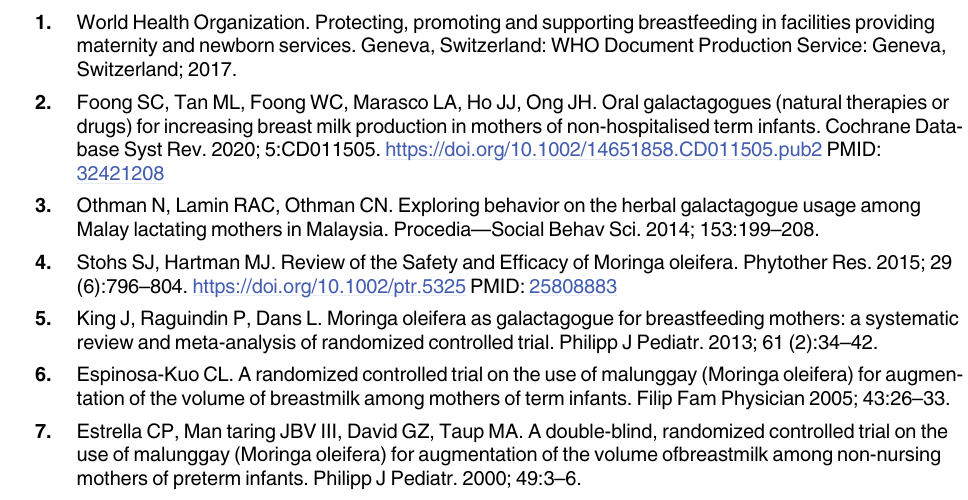
S1 Table. Baseline characteristics. S2 Table. Breast milk volume, satisfaction, quality of life and side